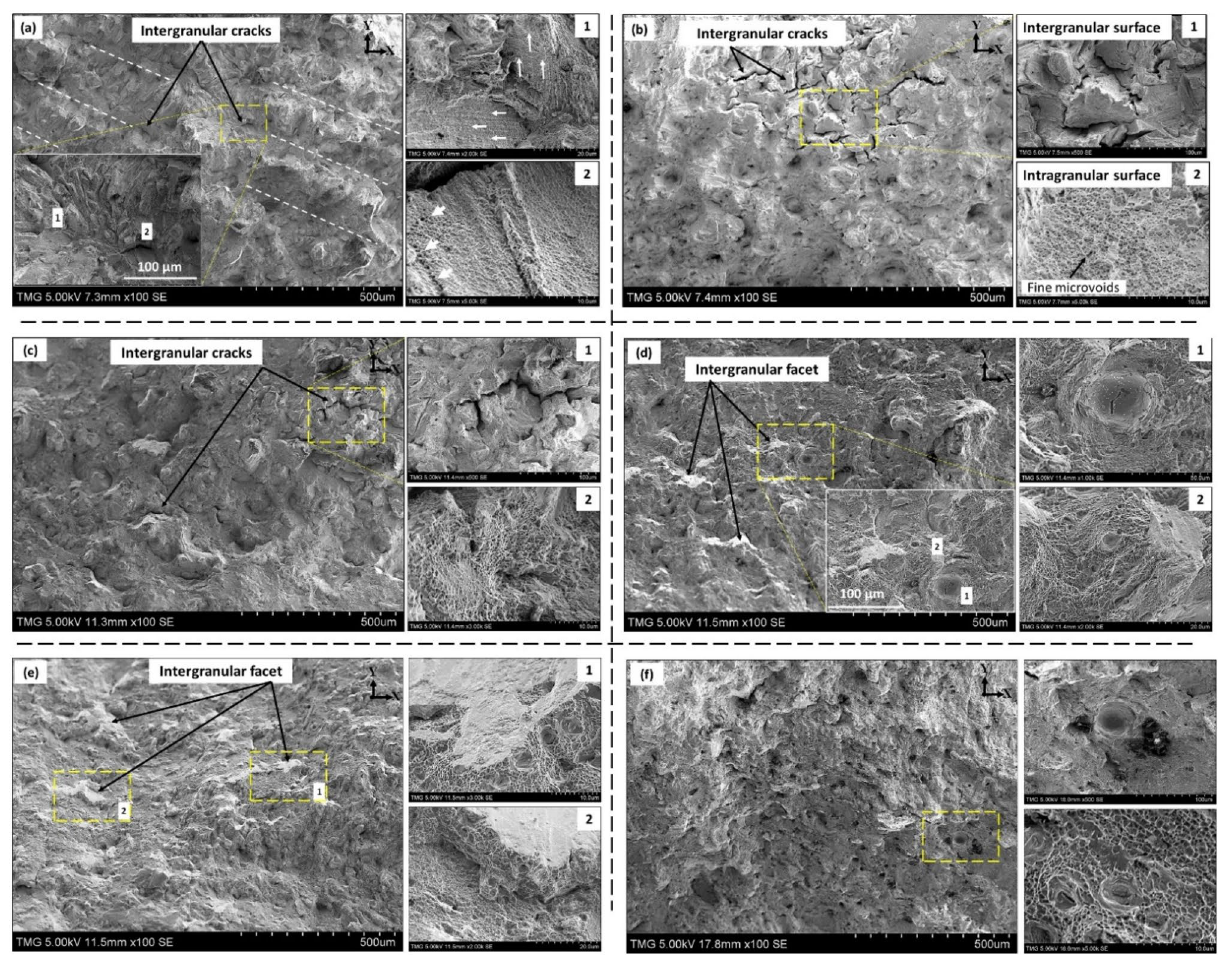
Figure 11. Fracture surface on the transverse plane of LPBF IN718: ( a ) as-printed; ( b ) HSA1; ( c ) HSA2; ( d ) HSA3; ( e ) HSA4; ( f ) HSA5. Fractures on melt-pool boundaries are highlighted by dotted lines in ( a ). Arrows in (a (1 and 2)) indicate the aligned intragranular dimples along the dendrites pattern in two different grains, and the coalescence of some microvoids along these dendrites,